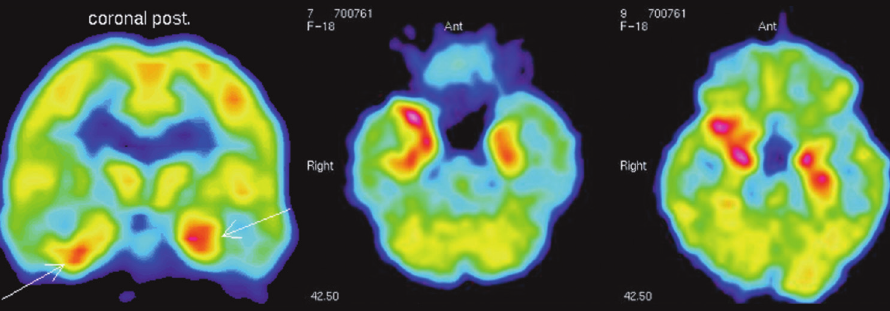
Figure 1. Patient with suspect CJD. The patient, however, had paraneoplasic limbic encephalitis. Left, coronal view: high FDG uptake bilaterally in the medial temporalcortex. Center and right: transaxial view. The FDG pattern is differ- ent to that seen in confirmed cases of CJD.